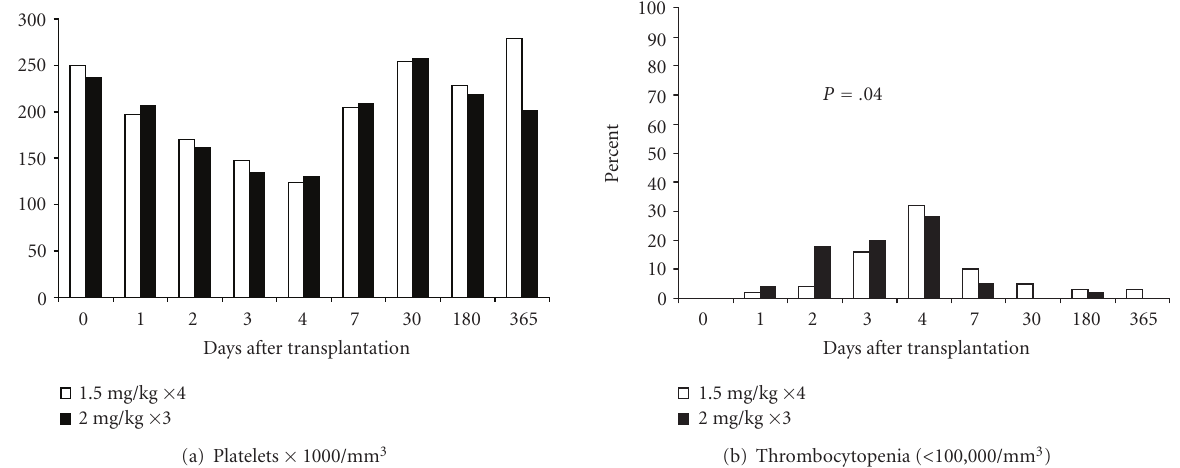
Figure 3: Figures 3(a), and 3(b). The mean platelet counts were similar throughout the study period, while the percentage of patients with thrombocytopenia was higher in the 2mg/kg arm on postoperative day 2. At 2 days postoperatively, 4% of the 1.5 mg/kg group’s patients had thrombocytopenia while 28% of the 2 mg/kg group had thrombocytopenia, P = .